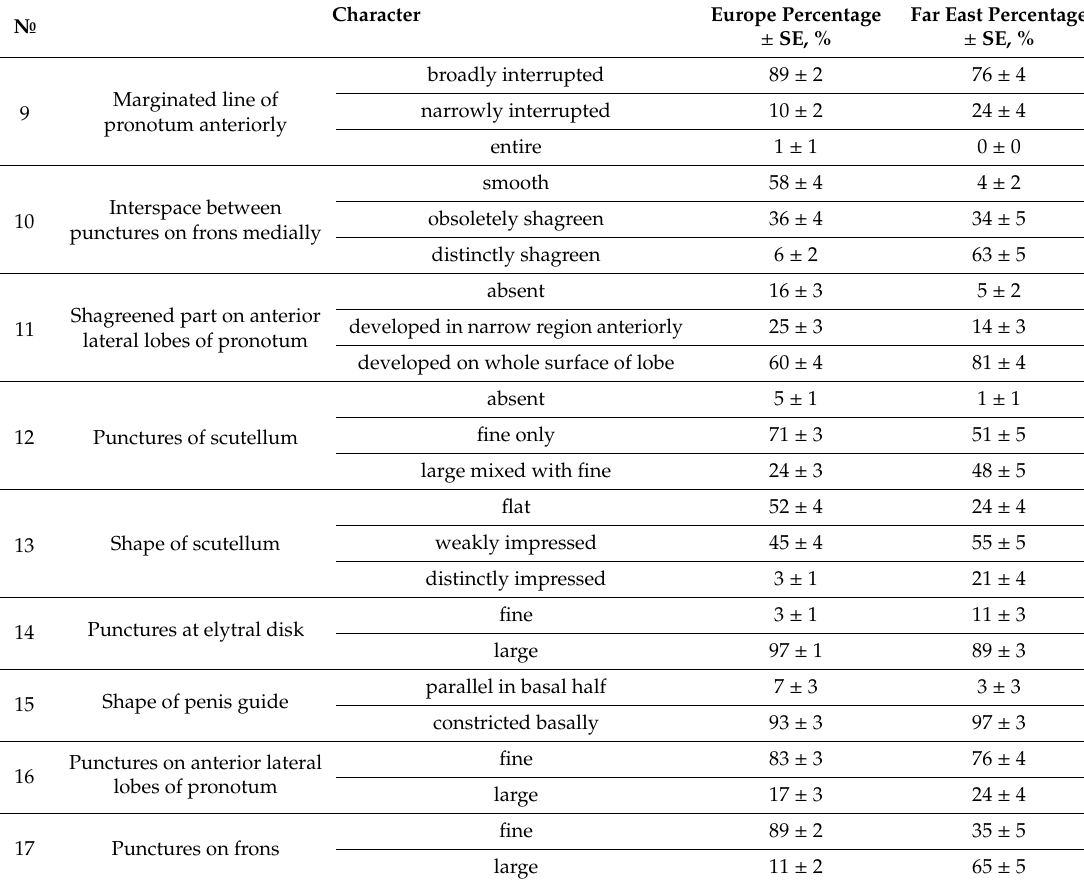
Table 3. Qualitative characters of the populations from Europe and the Far East. SE—standard error. Numbers of characters correspond to their numbers in the